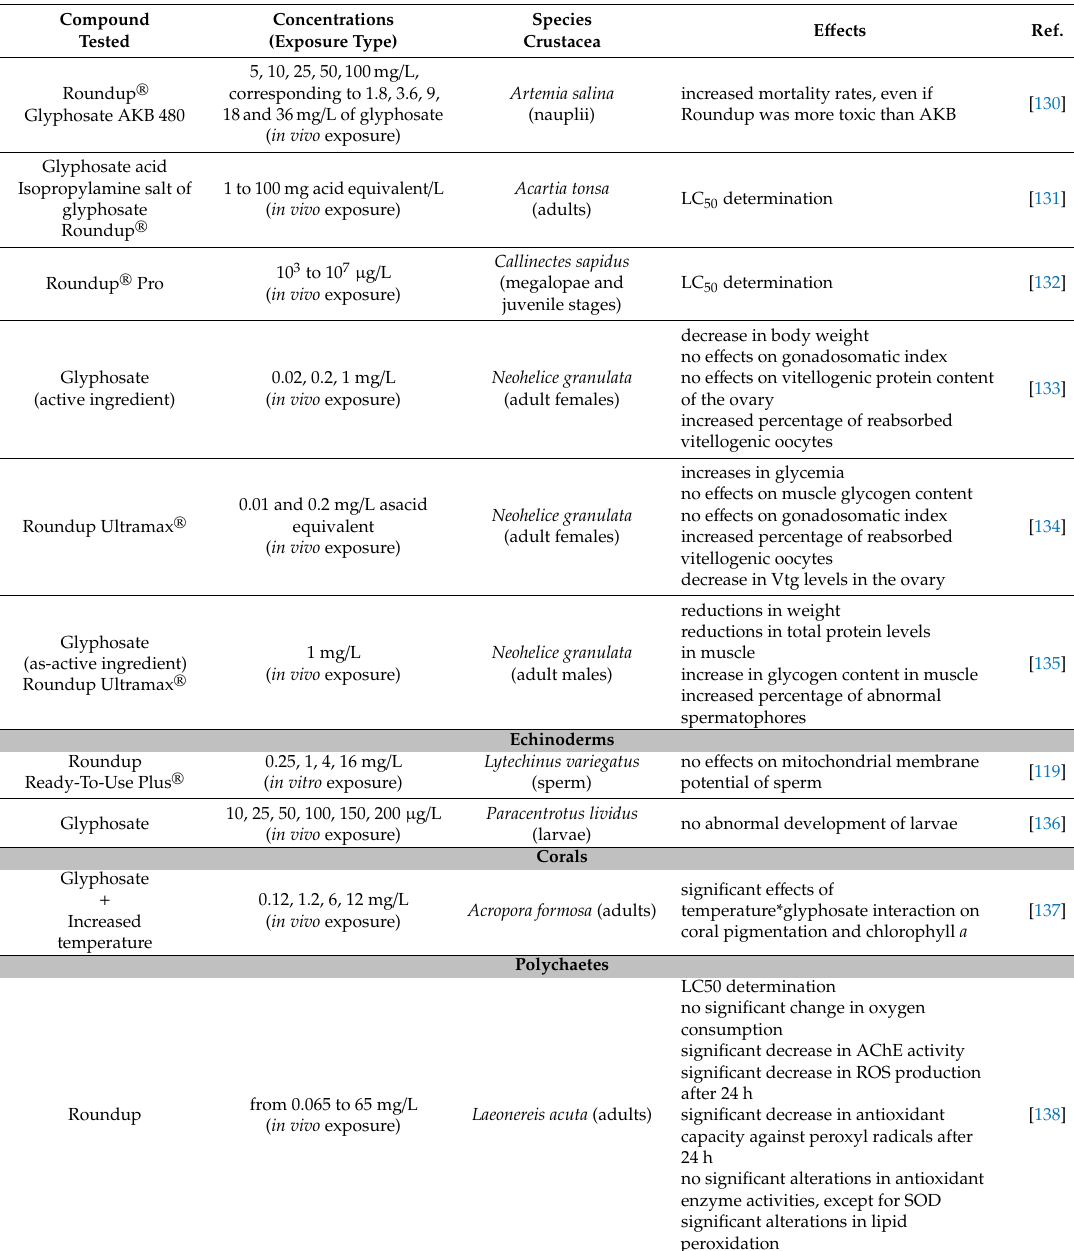
Table 4. E ff ects of glyphosate (as active ingredient) and its commercial formulations in other marine invertebrates. Abbreviations : AChE (acetylcholinesterase); LC50 (median lethal concentration); ROS (reactive oxygen species); SOD (superoxide dismutase); Vtg